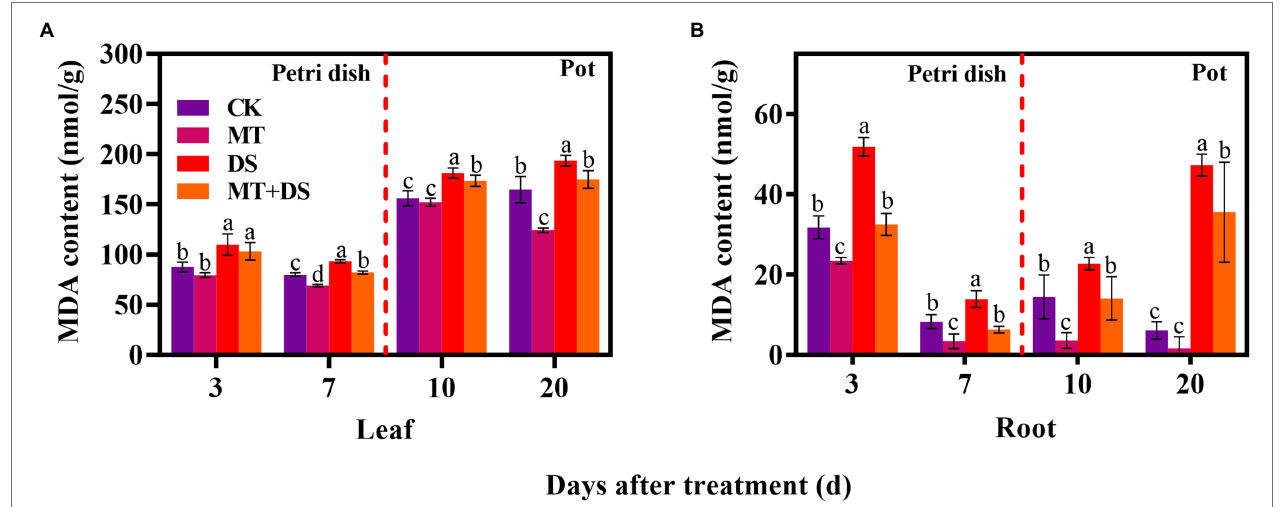
FIGURE 8 | In Petri dish, 20 μ M MT was used as the optimal priming treatment for triticale seeds priming (MT), 0 μ M MT as normal treatment (CK), 10% PEG as drought treatment (DS), and 20 μ M MT + 10% PEG treatment (MT+DS). In pot, 20 μ M MT was used as the optimal priming treatment for triticale seedlings, unprimed +70–75% relative water content as CK, primed +70–75% relative water content as MT, unprimed +40–45% relative water content as DS, and primed +40–45% relative water content as MT+DS. (A) MDA content in triticale seeds germinated in Petri dishes on 3 rd and 7 th days and potted seeding leaves on 10 th and 20 th d; and (B) MDA content in radicle of triticale seeds germinated in Petri dish on 3 rd and 7 th days and seedling roots on 10 th and 20 th days. For each trait, bars with the same letter are not significantly different ( p < 0.05). Different lower letters indicate significant differences among the treatments ( p < 0.05). Data shown are averages ± SE ( n = 6 in A,B ).